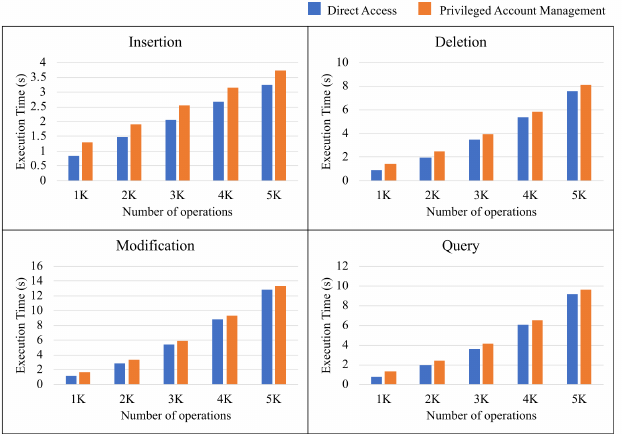
Figure 13. Comparison of execution time between direct access and secure access in scenario